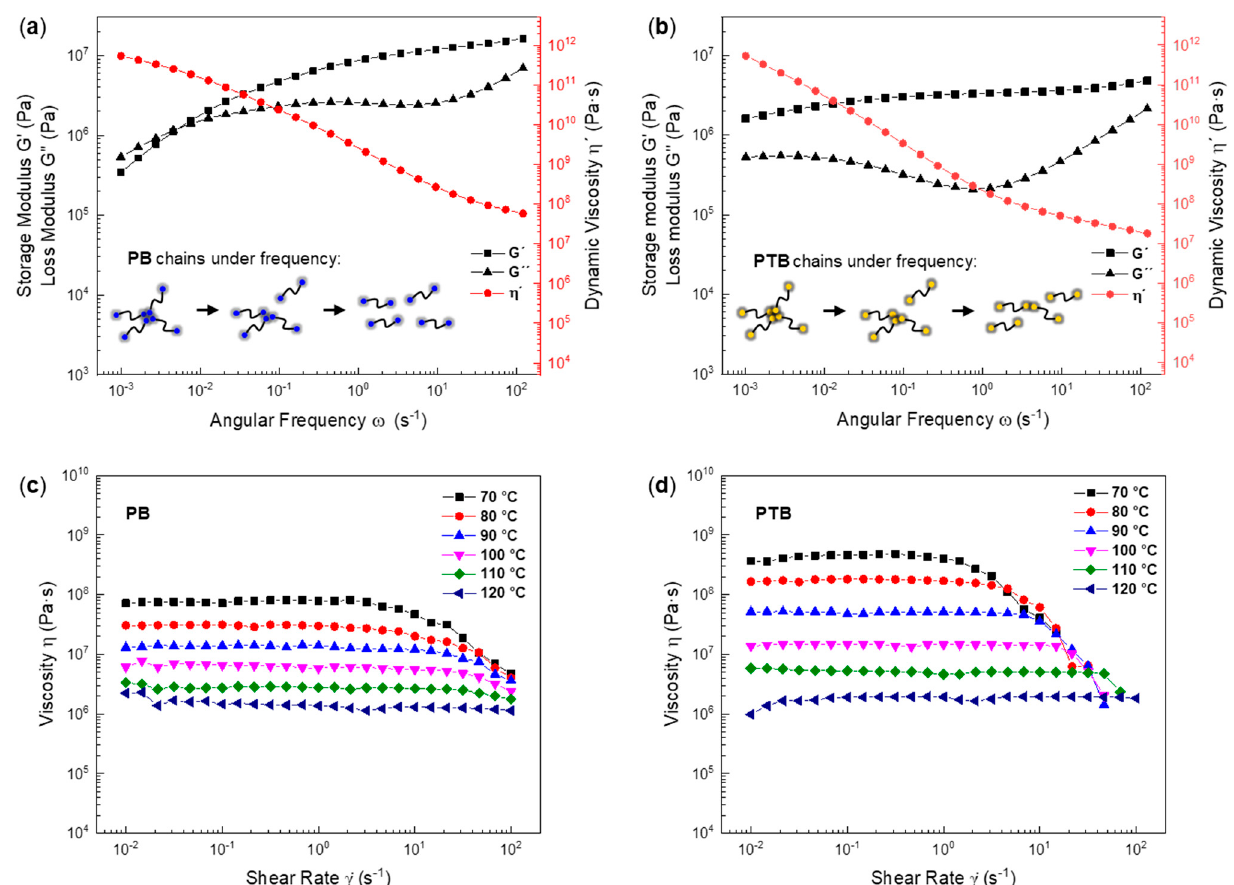
Figure 5. Storage modulus G ′ , loss modulus G ″ , and dynamic viscosity η′ vs . angular frequency ω measured at 20 °C, and viscosity η vs . shear rate γ̇ at elevated temperatures of the model polymer PB ( a , c ) and PTB ( b , d ).